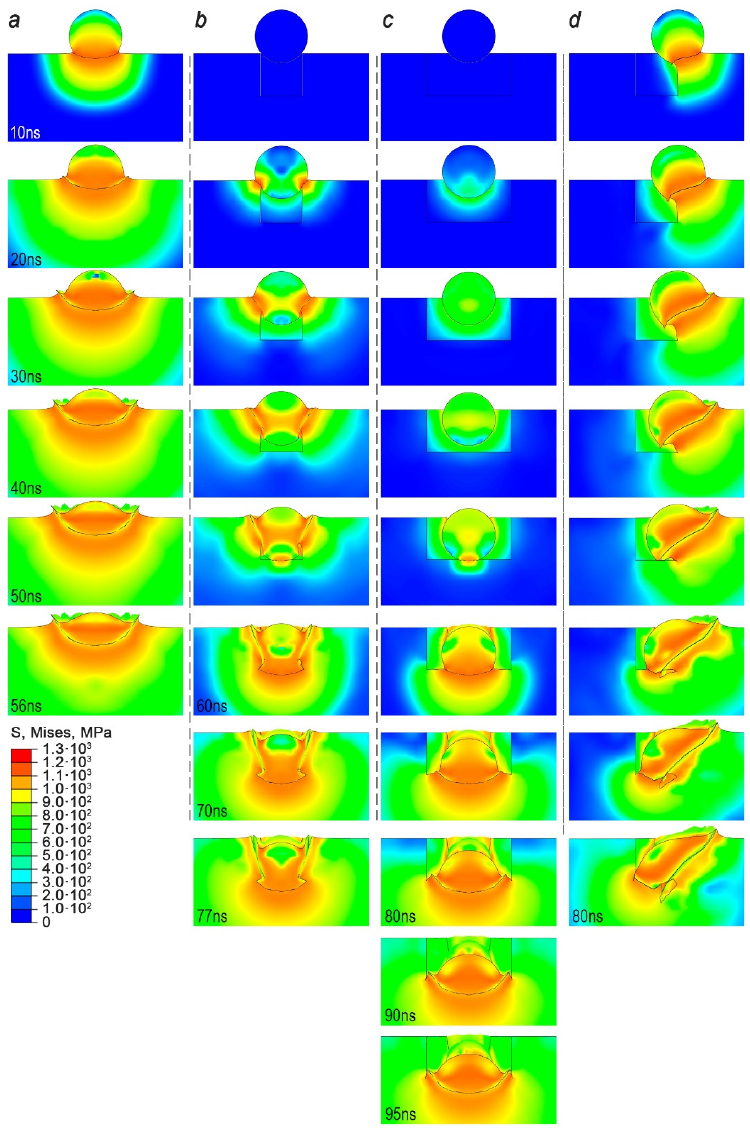
Figure 4. The von Mises stress distribution in the particle ( d P = 50 µ m) and substrate material by the time: ( a ) without microdefect; ( b ) with cube-shaped microdefect; ( c ) with rectangular-shaped microdefect; ( d ) with the particle collision on the edge of cube-shaped microdefect.